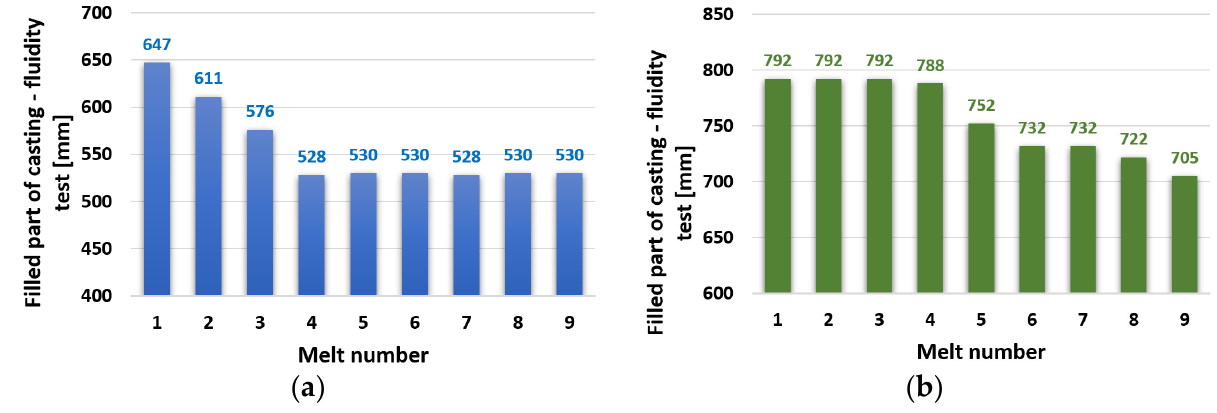
Figure 3. Dependence of spiral fluidity test length on the number of remelts: ( a ) ZnAl4Cu3 and ( b ) ZnAl4Cu3 with 3 wt.% Cd addition.